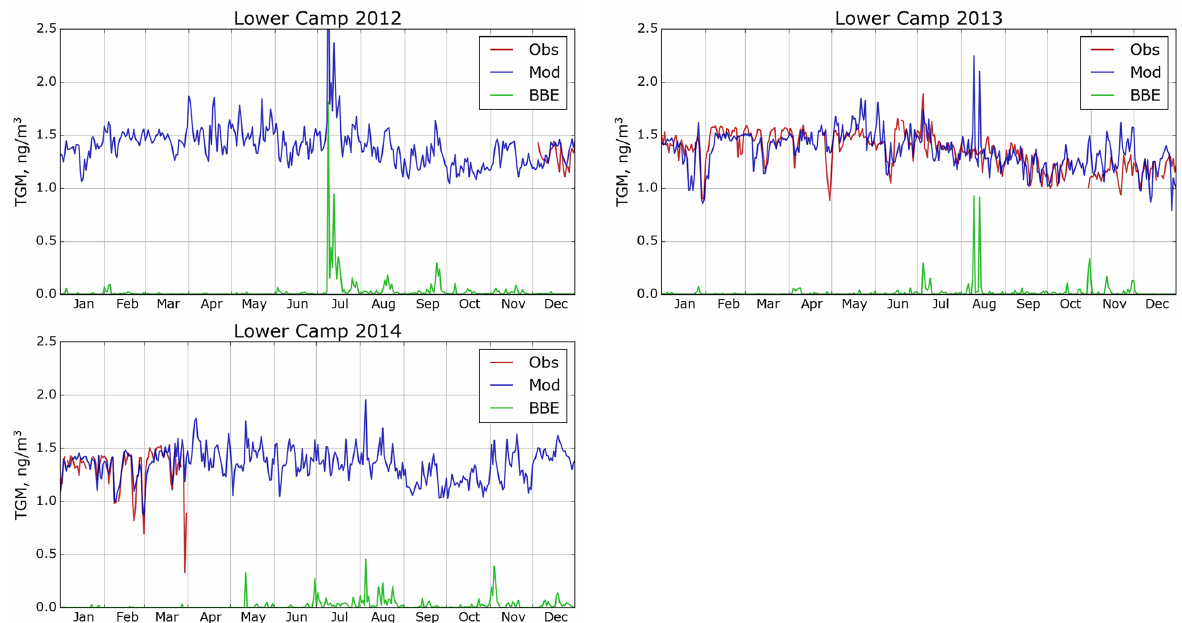
Figure 5. Simulated and observed surface air TGM concentrations in AOSR for the site Lower Camp (2012–2014). Obs – observations; Mod – model estimation; BBE – modelled biomass burning contribution.